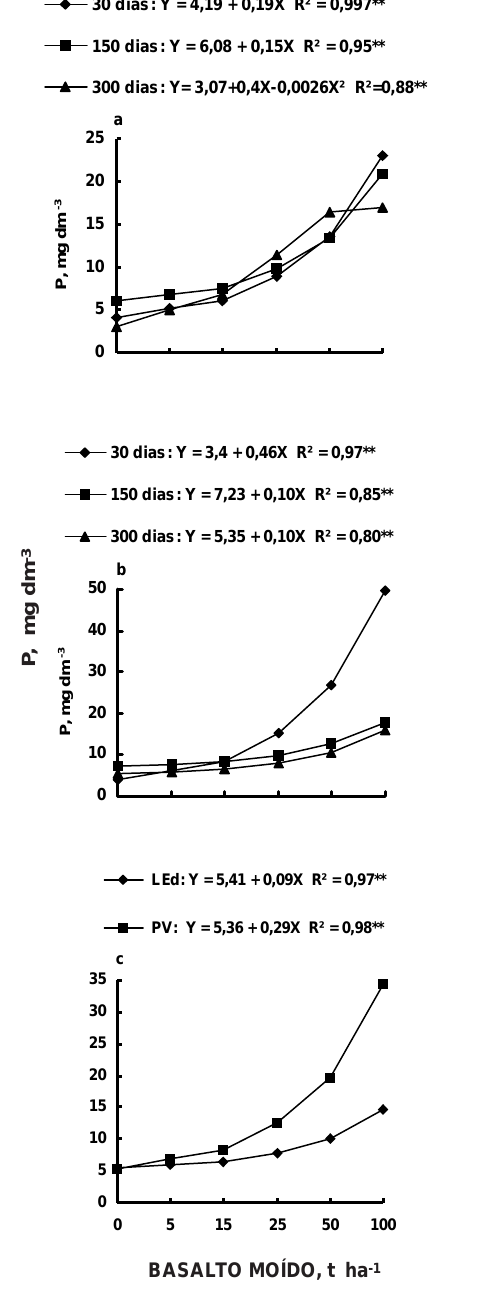
Figura 6. Concentração de P no solo. Média de solo para o basalto microcristalino (a) e para olivina- basalto (b), após 30, 150 e 300 dias de incubação de doses crescentes desses materiais. c: Média de período de incubação e rocha em um Latossolo Vermelho-Escuro (LEd) e em um Podzólico Vermelho-Amarelo